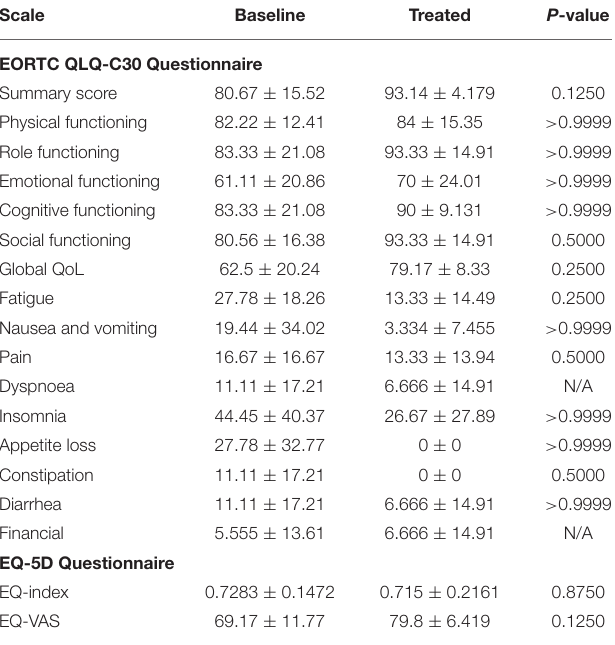
TABLE 5 | Quality of life